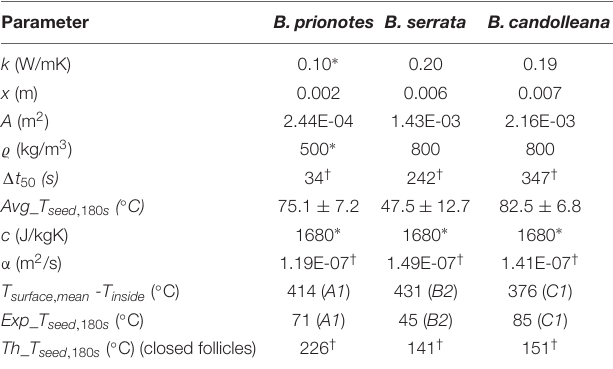
TABLE 1 | Overview of different follicle